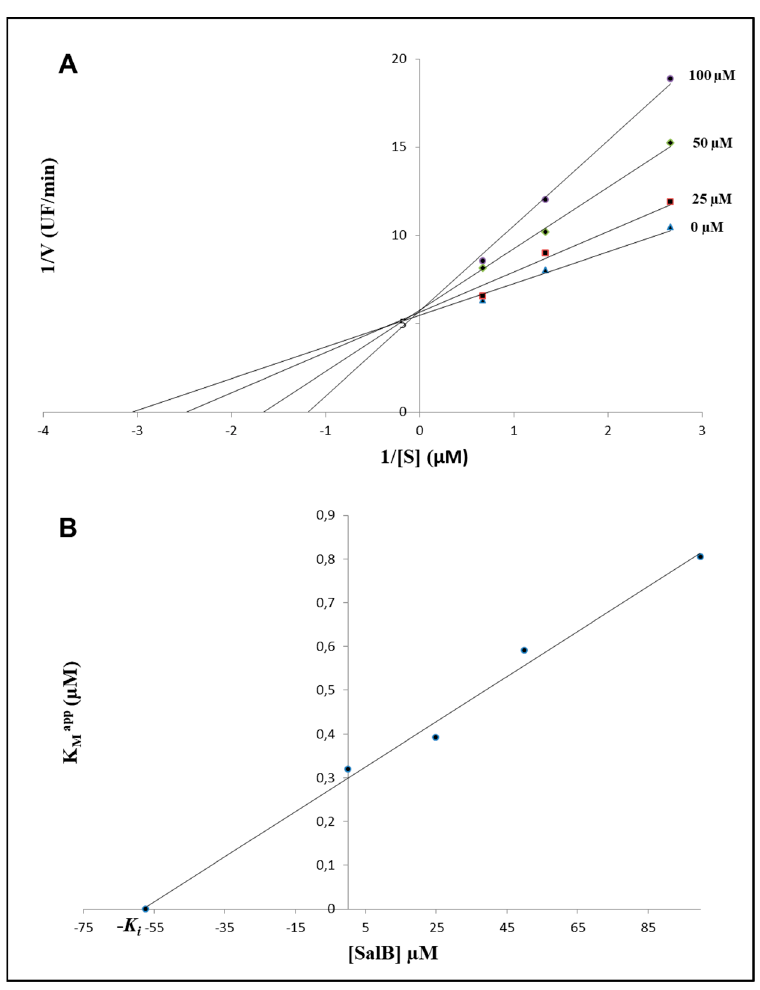
Figure 3. Kinetic analysis of SalB against the catalytic domain of MMP-9. ( A ) Double reciprocal plots of 1/V versus 1/[S] suggest the competitive inhibition of the activity performed by the catalytic domain of MMP-9 (CDMMP-9). ( B ) Secondary plot of K Mapp versus different SalB concentrations. The K i value of SalB against CDMMP-9 was calculated to be equal to 57.37 µM.